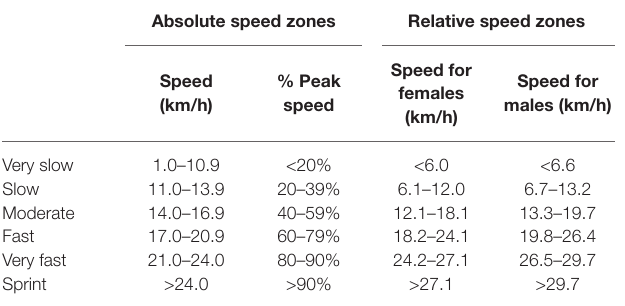
TABLE 1 | Absolute and relative speed zones used to examine intensity of skating